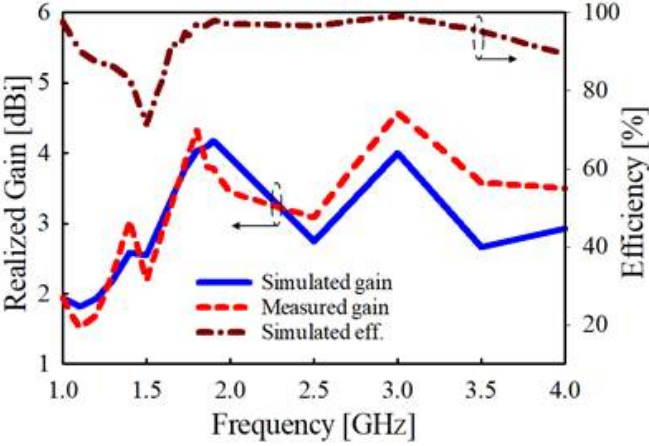
Figure 15. Results of the simulated and measured gain and antenna efficiency.